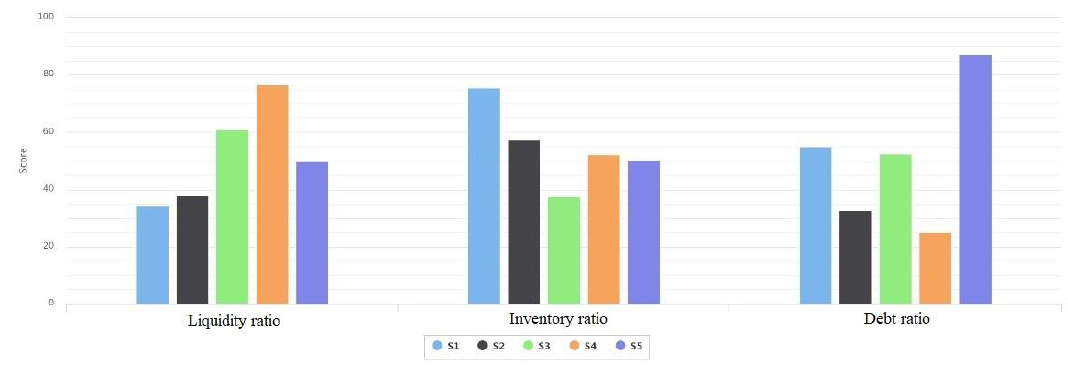
Figure 4. Supplier profiles for three financial ratios.